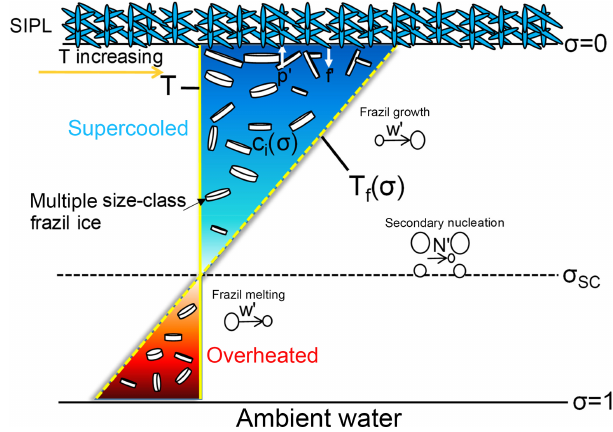
Figure 3. Schematic diagram of vertical distribution of thermal forcing and relevant processes within a supercooled ISW plume of homogeneous potential temperature and salinity. Secondary nucle- ation is the process by which the frazil ice in the smallest class is supplemented by collisions between other larger frazil-ice